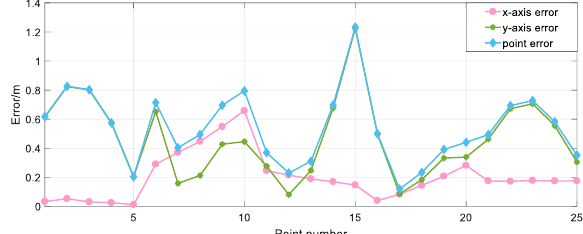
Figure 9 . Error of the calculated coordinates by monocular vision method based on plane